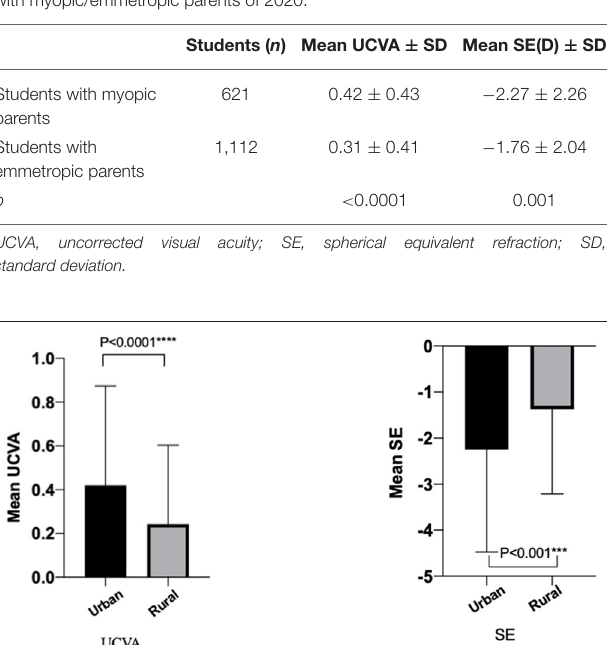
TABLE 2 | The mean uncorrected visual acuity and spherical equivalent refraction with myopic/emmetropic parents of 2020.